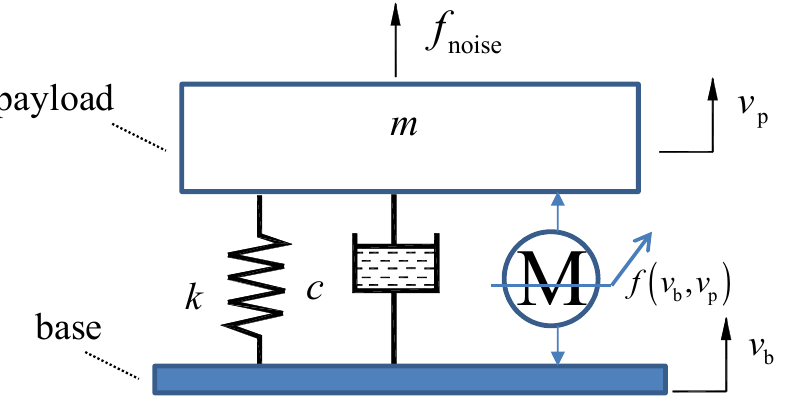
Figure 1. The single DOF mass-spring damping system with active control.